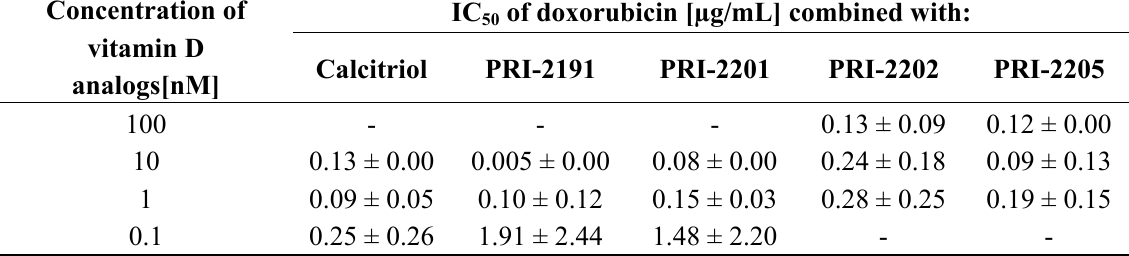
Table 4. The antiproliferative activity of doxorubicin used after preincubation with calcitriol or its analogs against HL-60 cells.